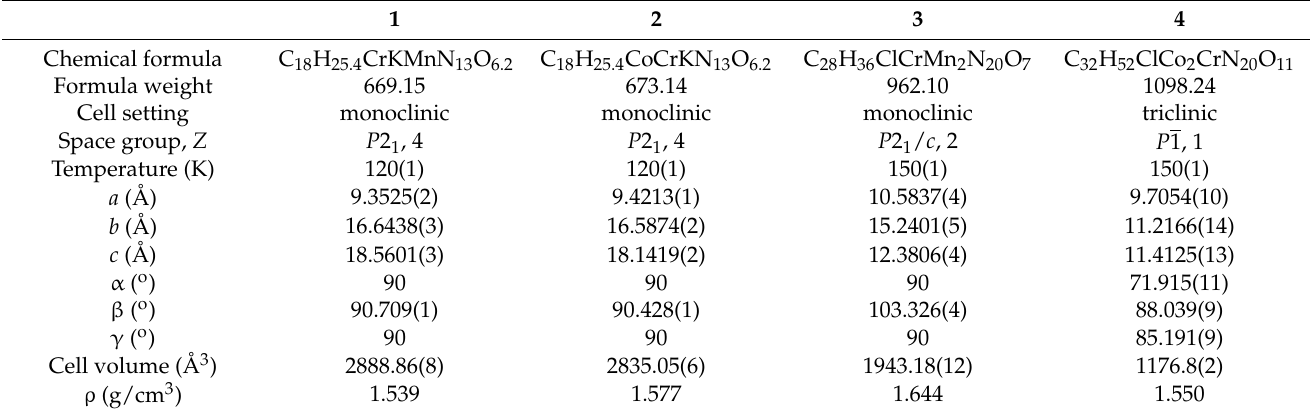
Table 1. Crystal data and structural refinement parameters for the complexes 1 – 4